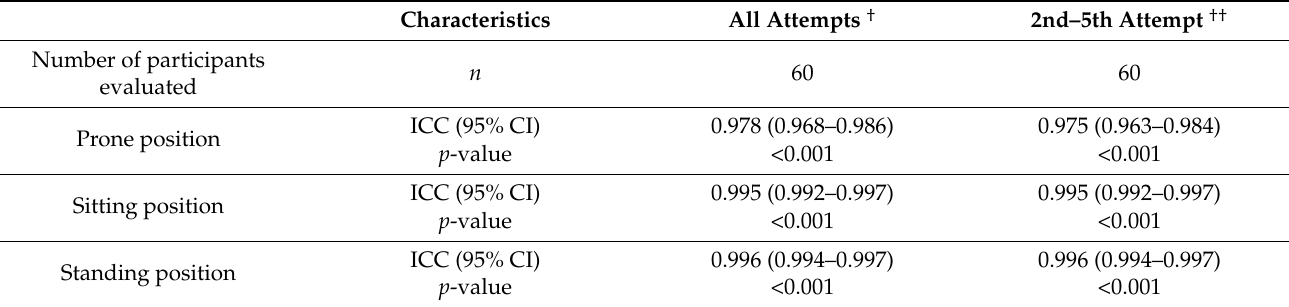
Table 3. Maximal isometric lower back extensor strength: